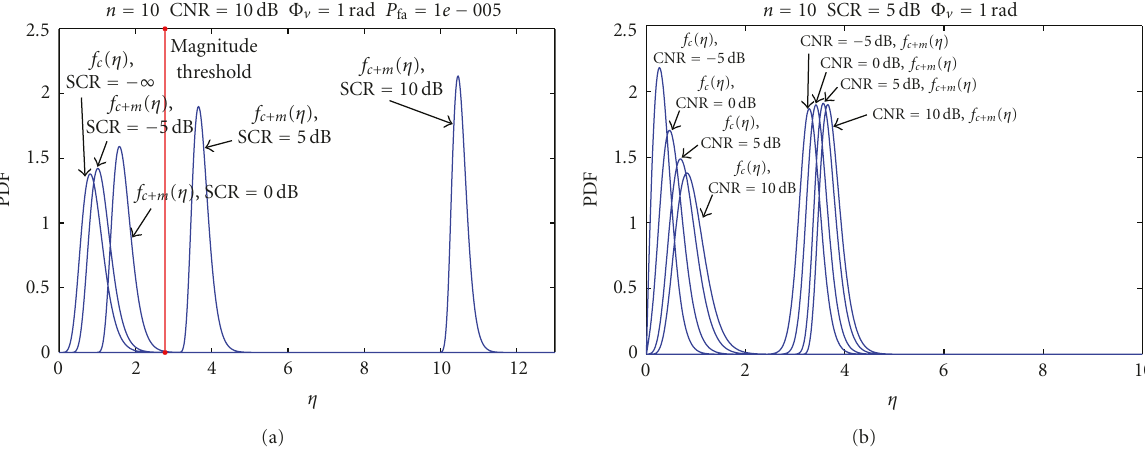
Figure 4: PDF of the interferometric magnitude of “clutter”and “clutter plus moving target” with η for n = 10, P fa = 1 e − 5, and Φ v = 1 rad. (a) CNR = 10dB, SCR = −∞ , − 5dB, 0 dB, 5dB, 10 dB; (b) SCR = 5dB, CNR = − 5 dB, 0dB, 5dB, 10 dB for f c ( η ) and f c + m ( η ).